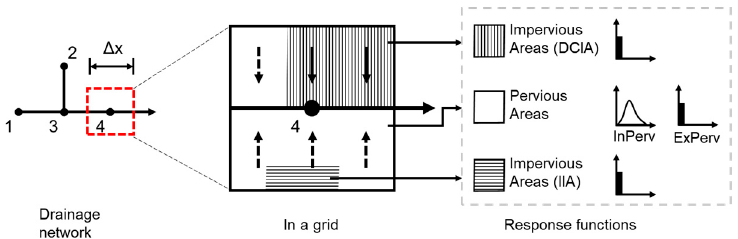
Figure 4. Response functions from each area (DCIA, IIA and pervious areas) contributing to runoff hydrographs. Table 2. Rainfall intensity for each contributing area in an urban catchment.